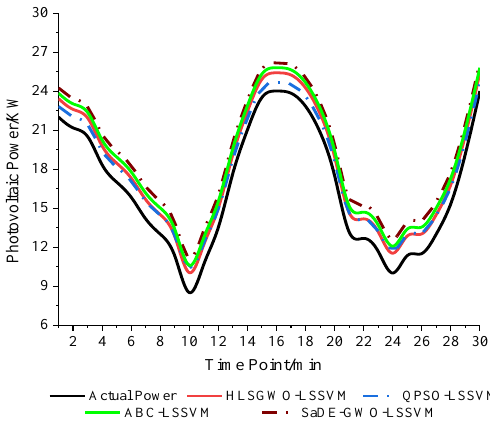
Figure 5. The fitting curve of the predicted power.